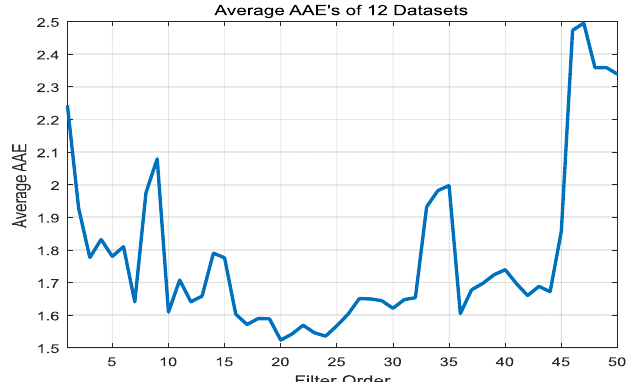
Figure 4. Average values of AAE’s using the linear filter with respect to various filter orders for 12 total datasets.